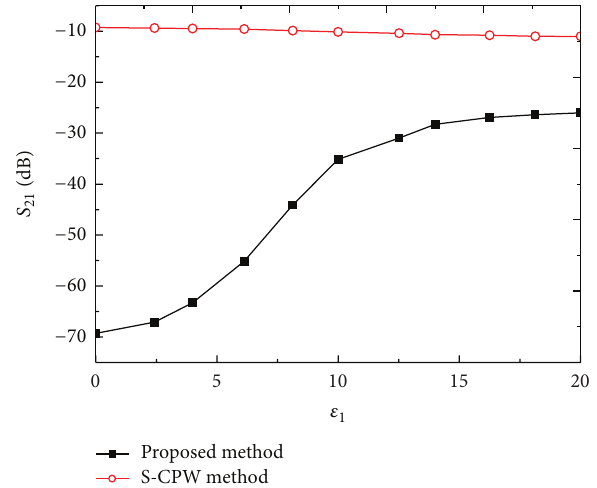
Figure 3: The scattering parameters 𝑆 21 change with various differ- ences of permittivity for two methods.